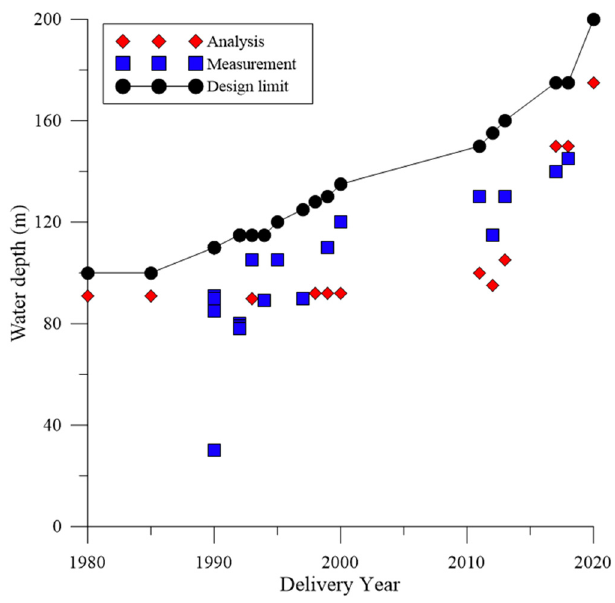
Figure 3. Distribution of the water depth according to delivery year for jack-up rigs .